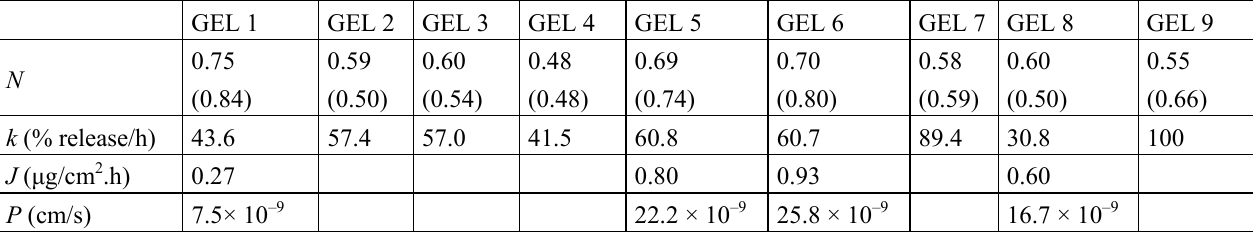
Table 2. Release ( N and k ) and permeation ( J and P ) parameters: the values, obtained using the new method, are in